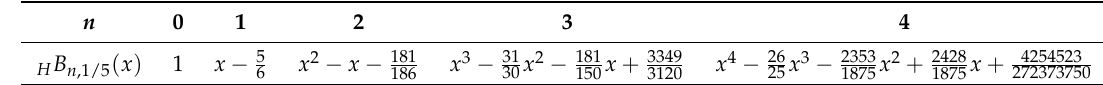
Table A1. Expressions of first five H B n ,1/5 ( x ) .